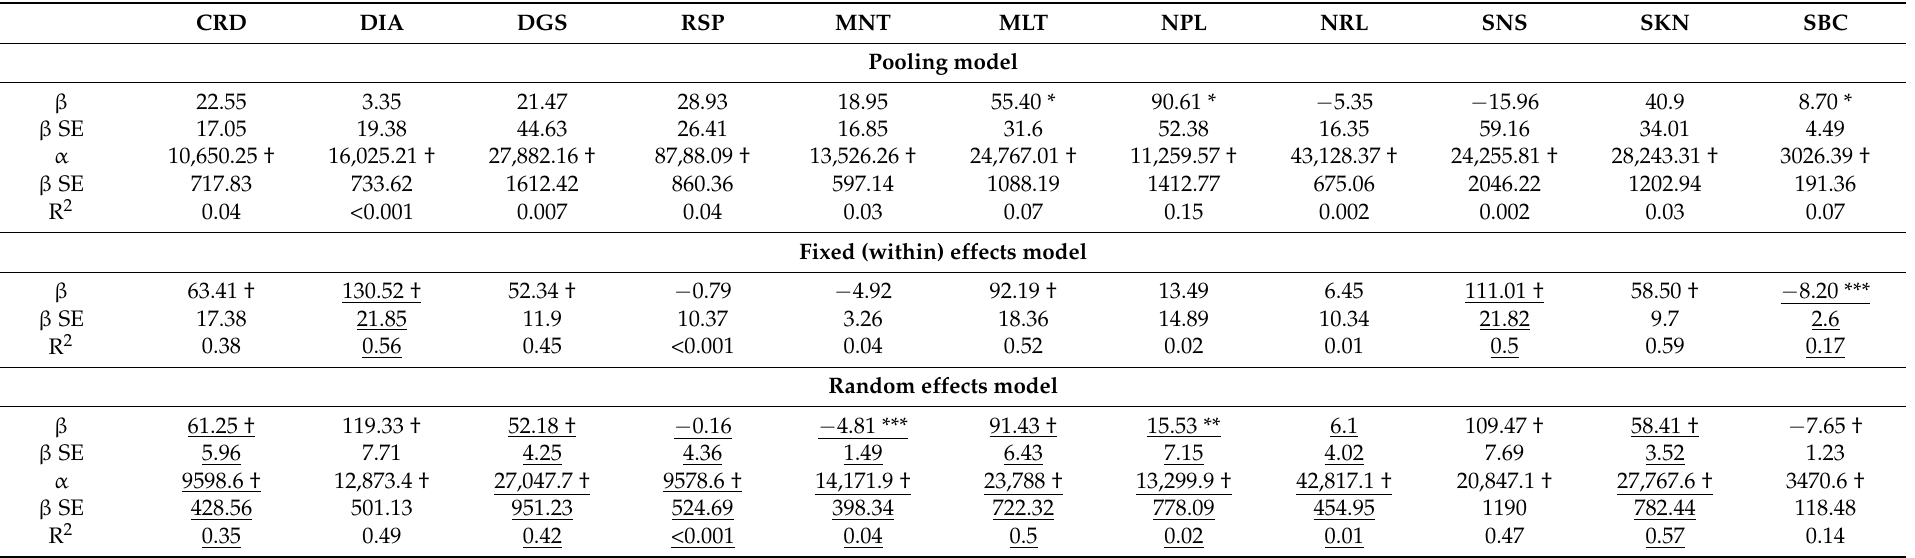
Table 5. Outputs of PLM models: RNWe electricity (%) → prevalence of selected diseases (per population of